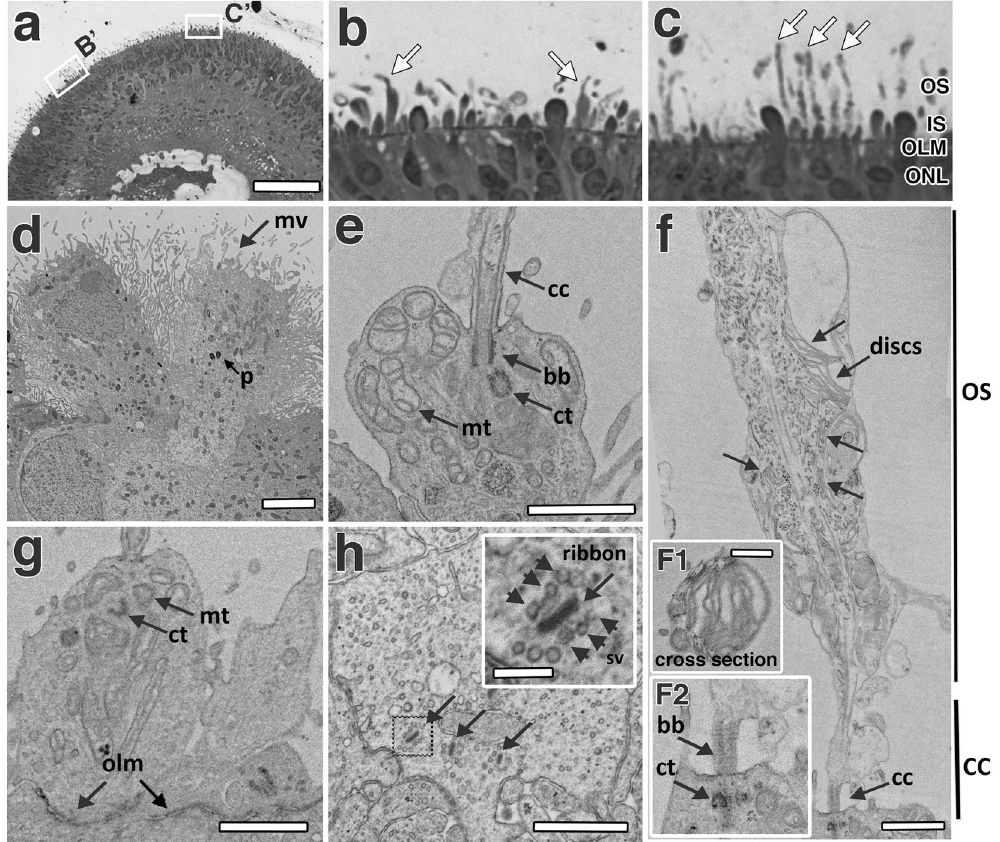
Figure 6. Electron micrographs of EP1-iPSCs derived retina cups at 160 days. ( a ) A one-micron thick section of a plastic embedded retina cup. Highlighted boxes (B’ and C’) are represented in panels ( b ) and ( c ) respectively. Arrows indicated in panel ( b ) represent cones while those in ( c ) indicate rods. 50 nm ultra-thin sections were imaged by standard EM. ( d ) Microvilli (mv) present on the surface of isolated RPE clumps RPE and pigment ( p ) within; ( e ) a PR inner segment with a connecting cilium (cc), mitochondria (mt), a centriole (ct), and basal body (bb); ( f ) a PR with a connecting cilium bearing a rudimentary outer segment with stacks of discs (arrows). ( F1 ) Panel illustrates a cross section of a POS bearing organized discs while ( F2 ) shows the basal body and centriole; ( g ) a PR inner segment with an intact outer limiting membrane; ( h ) a PR synaptic terminal with synaptic vesicles (arrowheads) docked at electron dense ribbons (arrows). PR = photoreceptor, RC = retina cup; RPE = retinal pigment epithelium. Scale bars ( a ) = 300 μ m, ( d ) = 4 μ m, ( e ) = 1 μ m, ( f ) = 1 μ m, F1 = 500 nm, ( g ) = 1 μ m, ( h ) (inset) = 200 nm, ( h ) = 1 μ